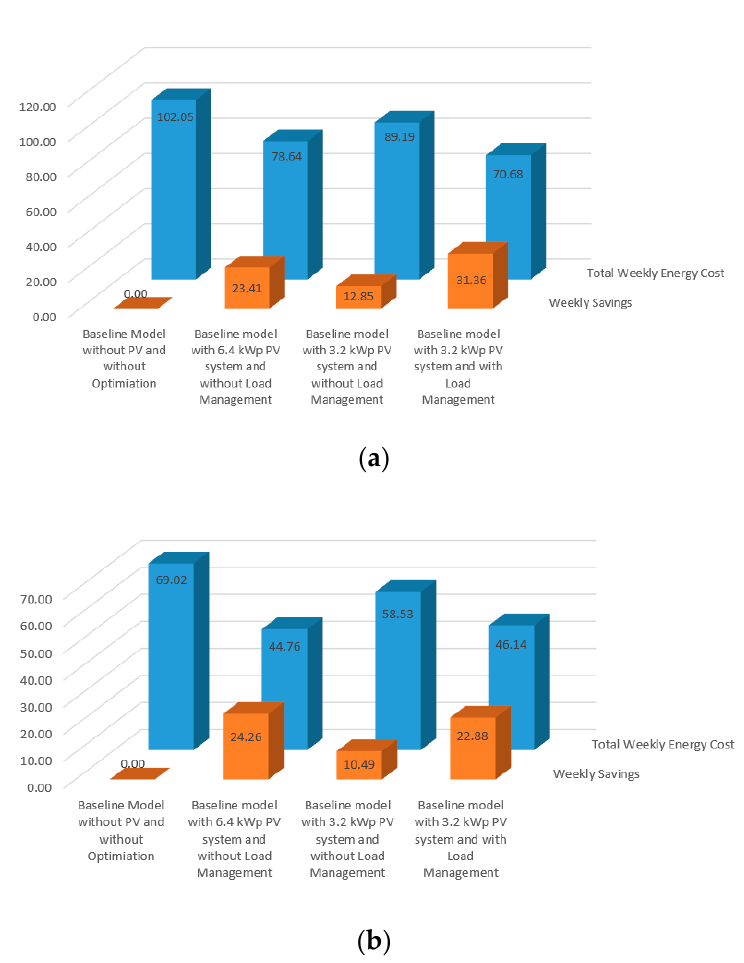
Figure 8. ( a ) Summer week—Savings after reduction of the PV System size; ( b ) Spring week—Savings after reduction of the PV System size.